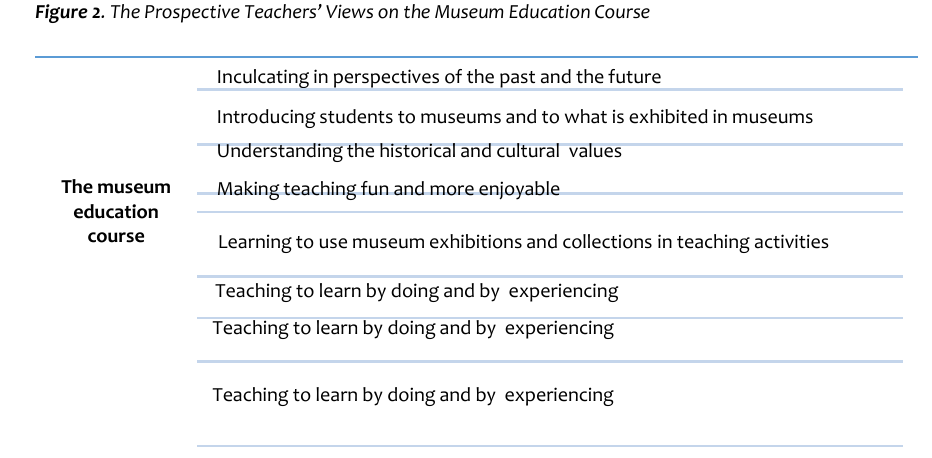
Figure 2 . The Prospective Teachers’ Views on the Museum Education